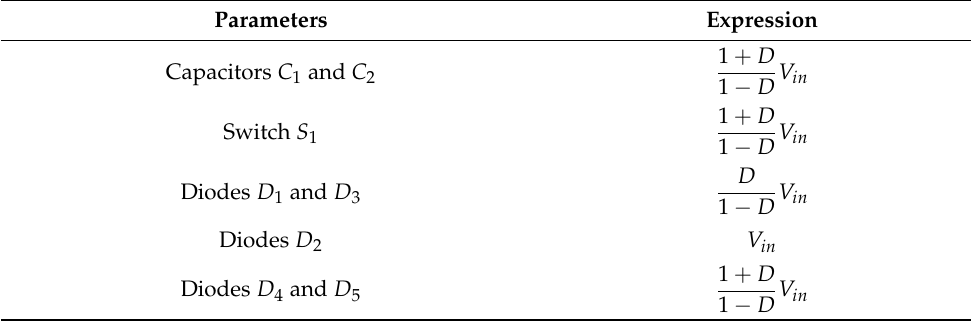
Table 1. Equations of voltages for type-1 SLSC CUK converter.